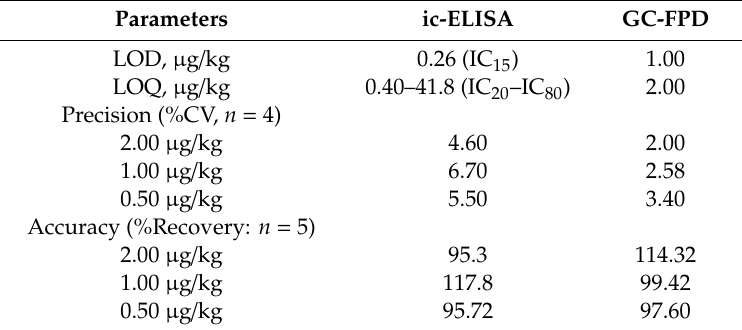
Table 2. Accuracy, precision, limit of detection (LOD), and limit of quantification (LOQ) of the developed